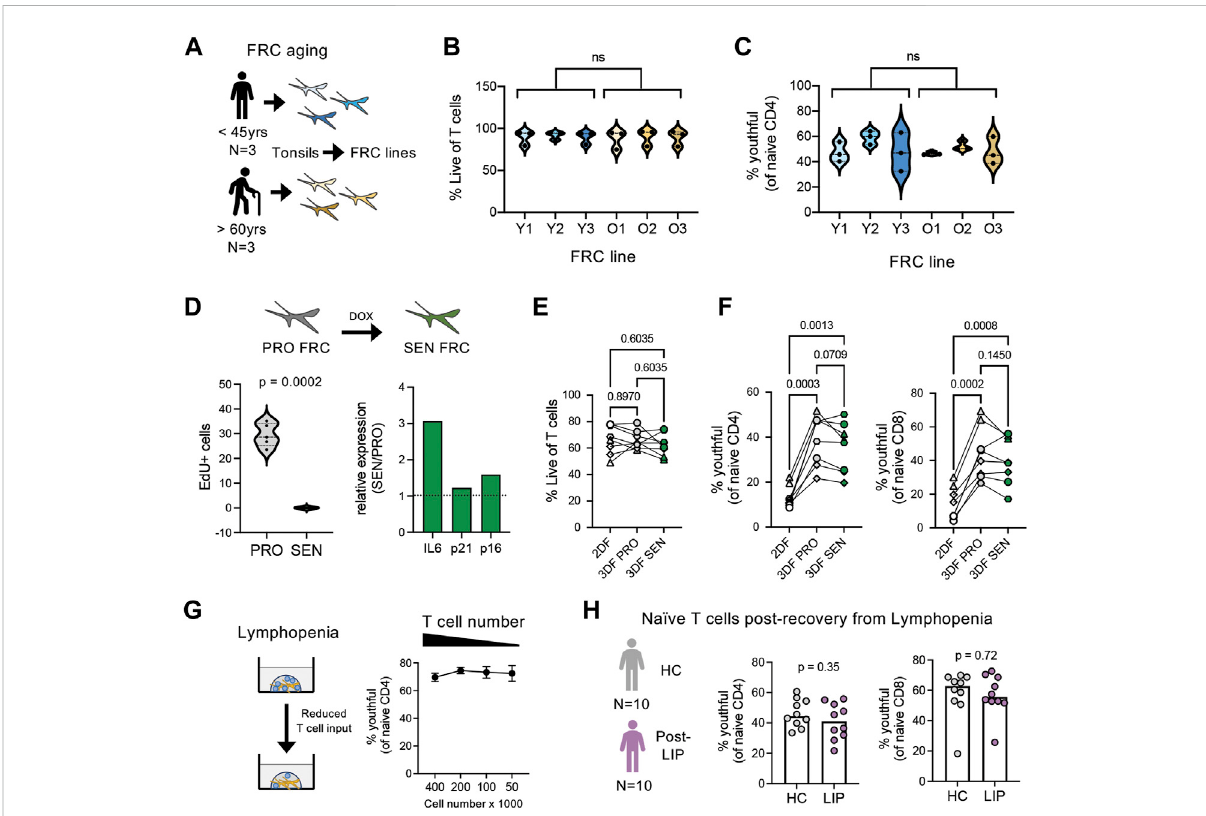
FIGURE 6 Effects of FRC aging, senescence, and lymphopenia on naïve T cell aging. (A) Overview of fi broblastic reticular cell isolation from young ( n = 3; 27,31,and41 yearsold)andolder( n =3;85,94,and96 yearsold)adults. (B) Tcellviabilityand (C) CD45RA high CD27 high naïveCD4Tcellsafter14 days organoid cultures ( n = 3 young T cell donors) with FRCs isolated from young or older adults. (D) Overview and characterization of senescent FRCs generated from FRCs from young tissue donor. Relative gene expression of IL-6, p21 and p16 determined by qPCR, normalized to RPLP0controlgene. (E) PercentLiveTcellsand (F) frequenciesofCD45RA high CD27 high naïveCD4andCD8Tcellsin2DF(comparisoncontrol)or3DF with proliferating (PRO) or senescent (SEN) FRCs. T cells are from four different young donors, performed in duplicate. (G) Effect of T cell input number on CD45RA high CD27 high naïve CD4 T cell frequencies in young donors ( n = 4) after 14 days organoid cultures. (H) Frequencies of CD45RA high CD27 high CD38 + CD25 neg naïve CD4 and CD8 T cells in cohort of patients 1 – 2 years after chemotherapy induced lymphopenia ( n = 10) compared with control cohort ( n = 10). ns, not signi fi cant. p -values determined by (B,C) paired t -test, (E – G) RM one-way ANOVA with Holm-Sidak multiple comparisons tests and (H) Mann-Whitney